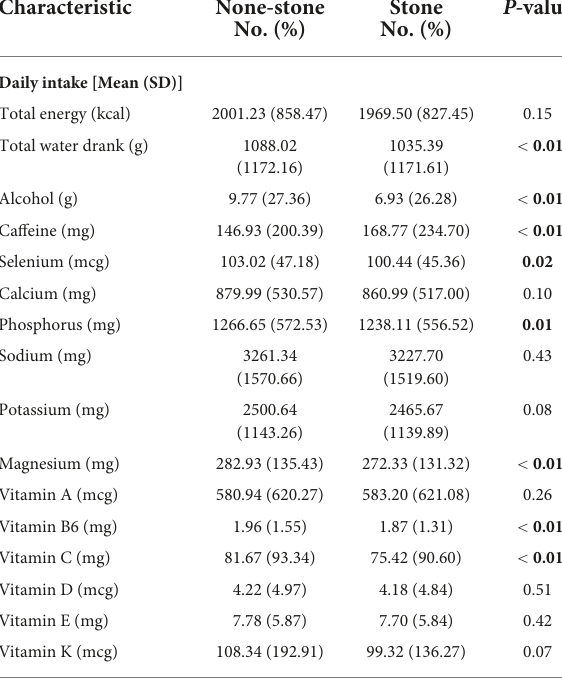
TABLE 1 Characteristics of participants in National Health and Nutrition Examination Survey (NHANES)